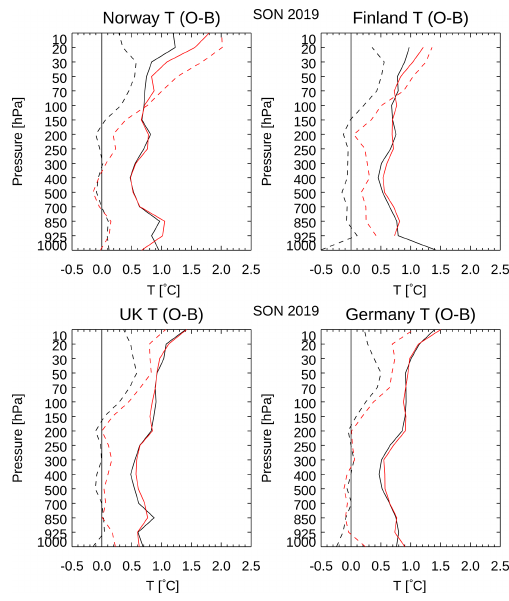
Figure 13. Figure 13 is the same as Fig. 10 but for